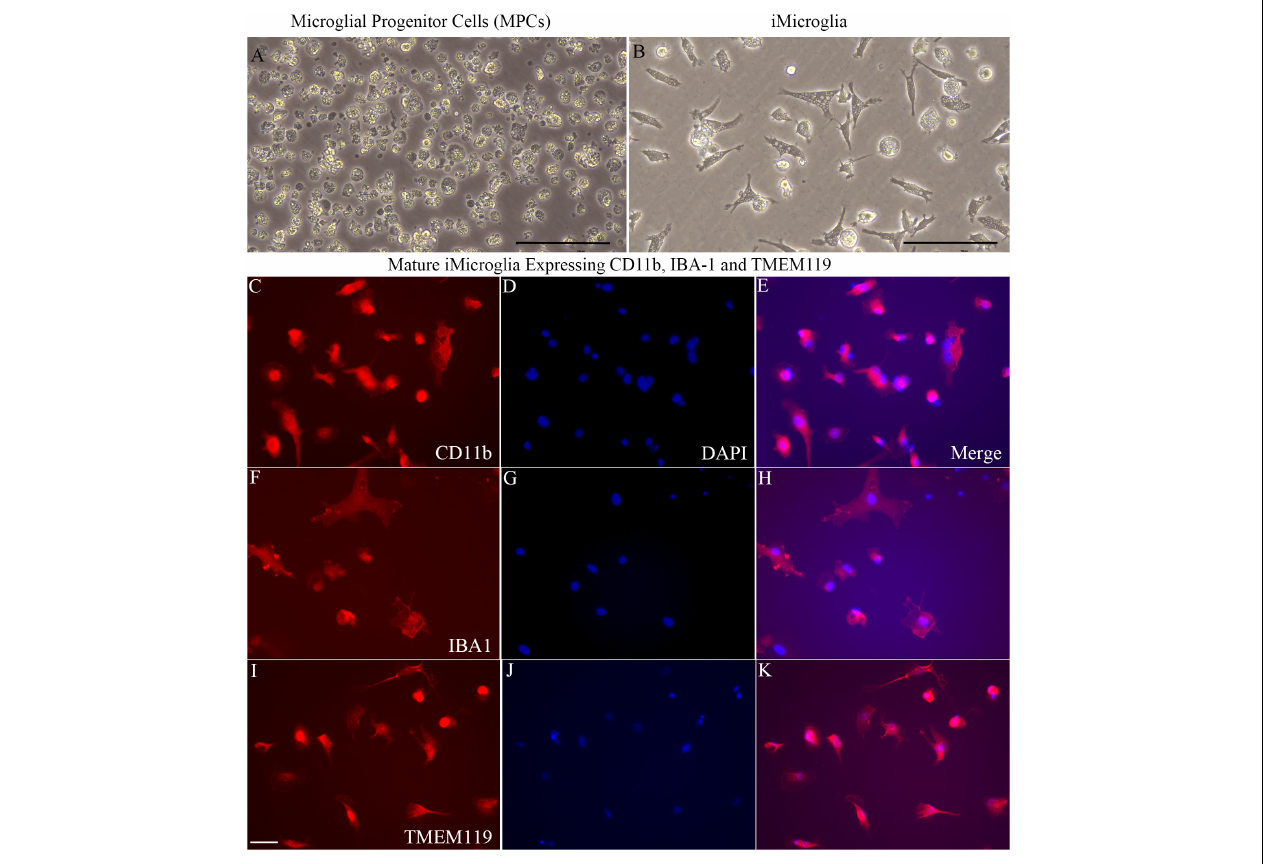
FIGURE 2 | Microglial progenitors from human induced pluripotent stem cells (hiPSCs) differentiate into mature iMicroglia expressing microglia-specific markers. (A,B) Illustrate phase contract images of microglial progenitor cells derived from hiPSCs (A) and mature iMicroglia (B) . (C–K) Show the morphology of